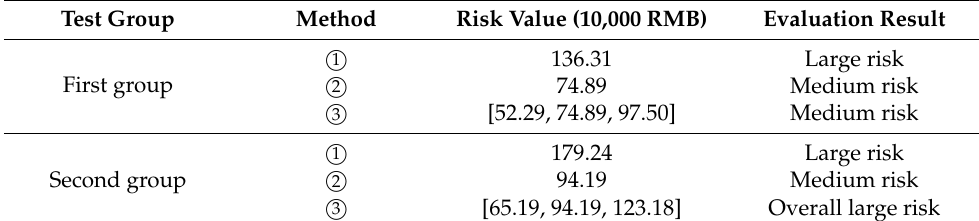
Table 10. Comparison of the evaluation results of the different